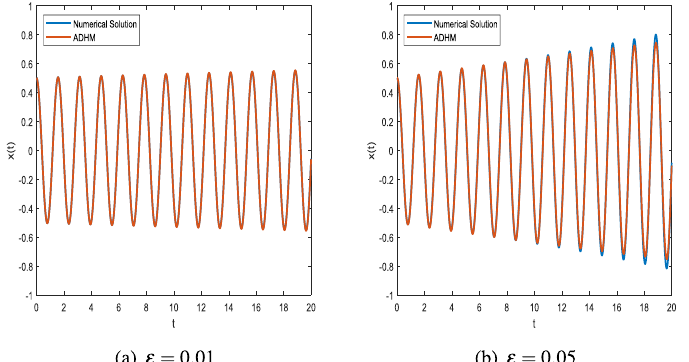
Figure 6. Comparison of ADHM results and numerical solution for parametric values x 0 = 0.5 and ω = 4